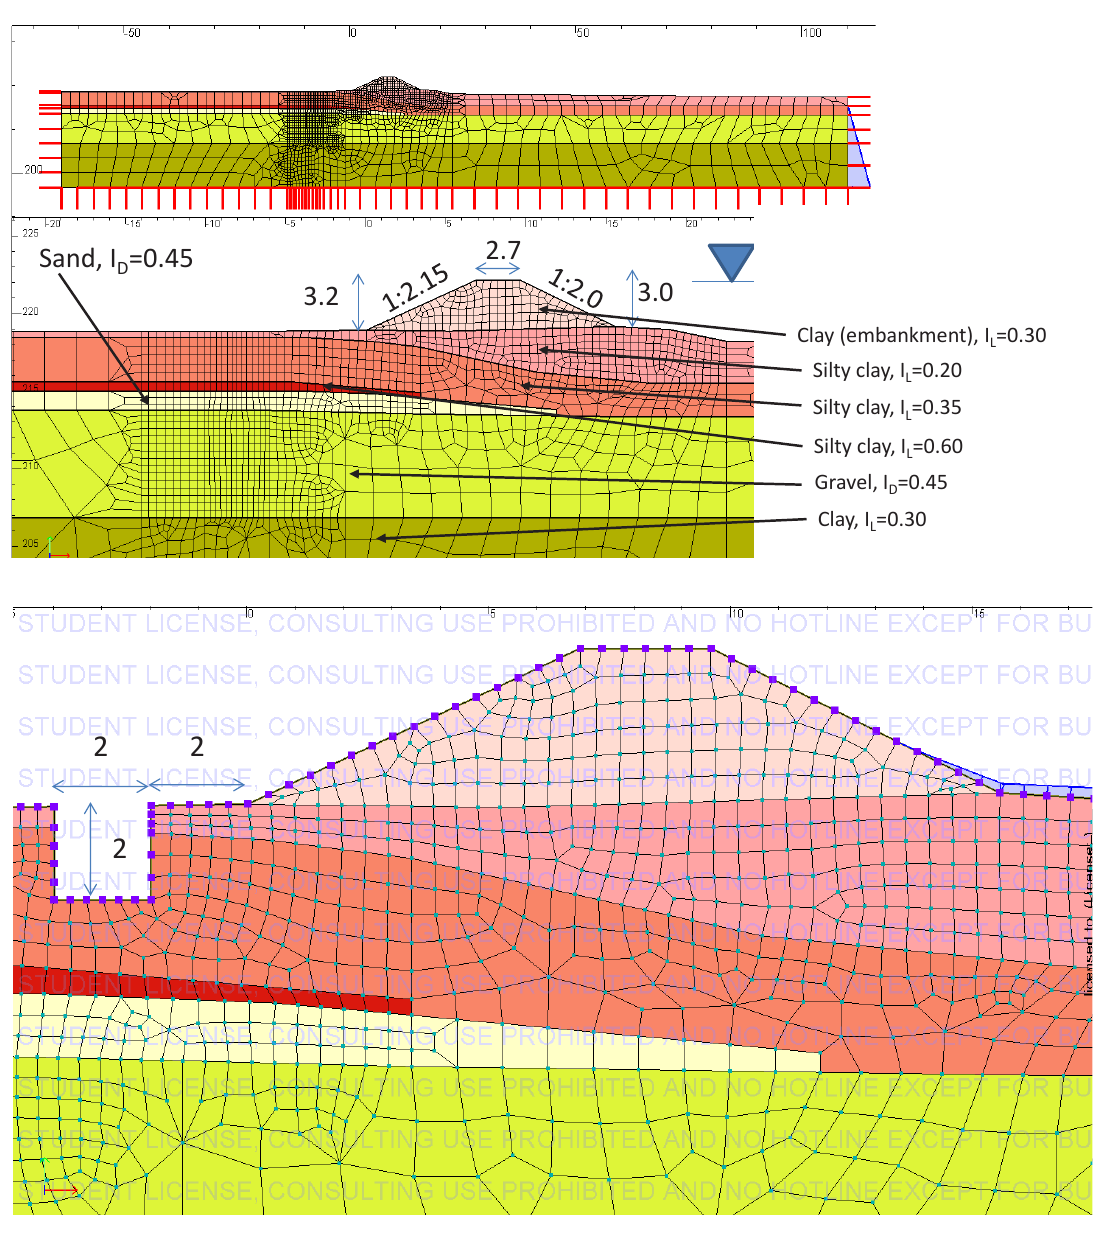
Figure 5: Numerical model of the embankment (a) with shallow excavation existing state and (b) with open